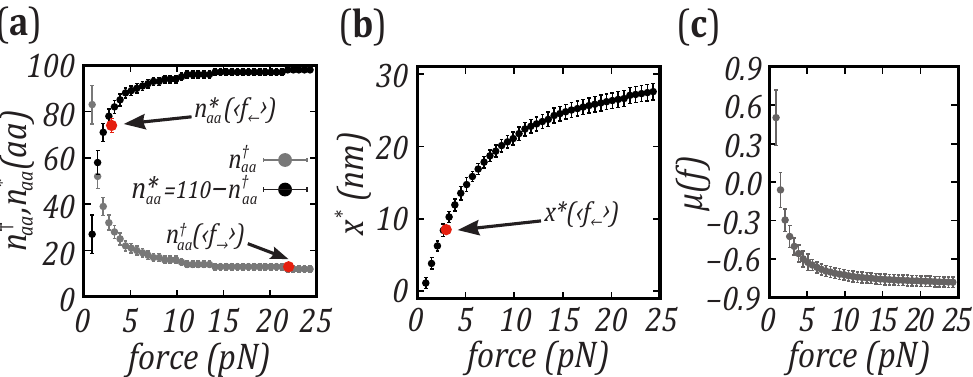
Figure 4. Force-dependent TS position. ( a ) Number of released and absorbed amino acids at TS relative to N , n † aa (gray), and U , n ∗ aa (black), respectively. The force dependence of n † aa is evaluated assuming a constant x † and using the WLC model; the values of n ∗ aa are calculated as 110 − n † aa . The red circles show the values of n † aa and n ∗ aa calculated at the most probable unfolding and refolding forces, by fitting the BE model to the experimental kinetic rates. ( b ) TS position relative to U , x ∗ , versus force. The values of x ∗ are derived by using Equation (6) and the values of n ∗ aa reported in ( a ). The red circle represents the value of x ∗ calculated at the most probable folding force, by using the experimental folding kinetic rates. ( c ) Fragility of barnase versus